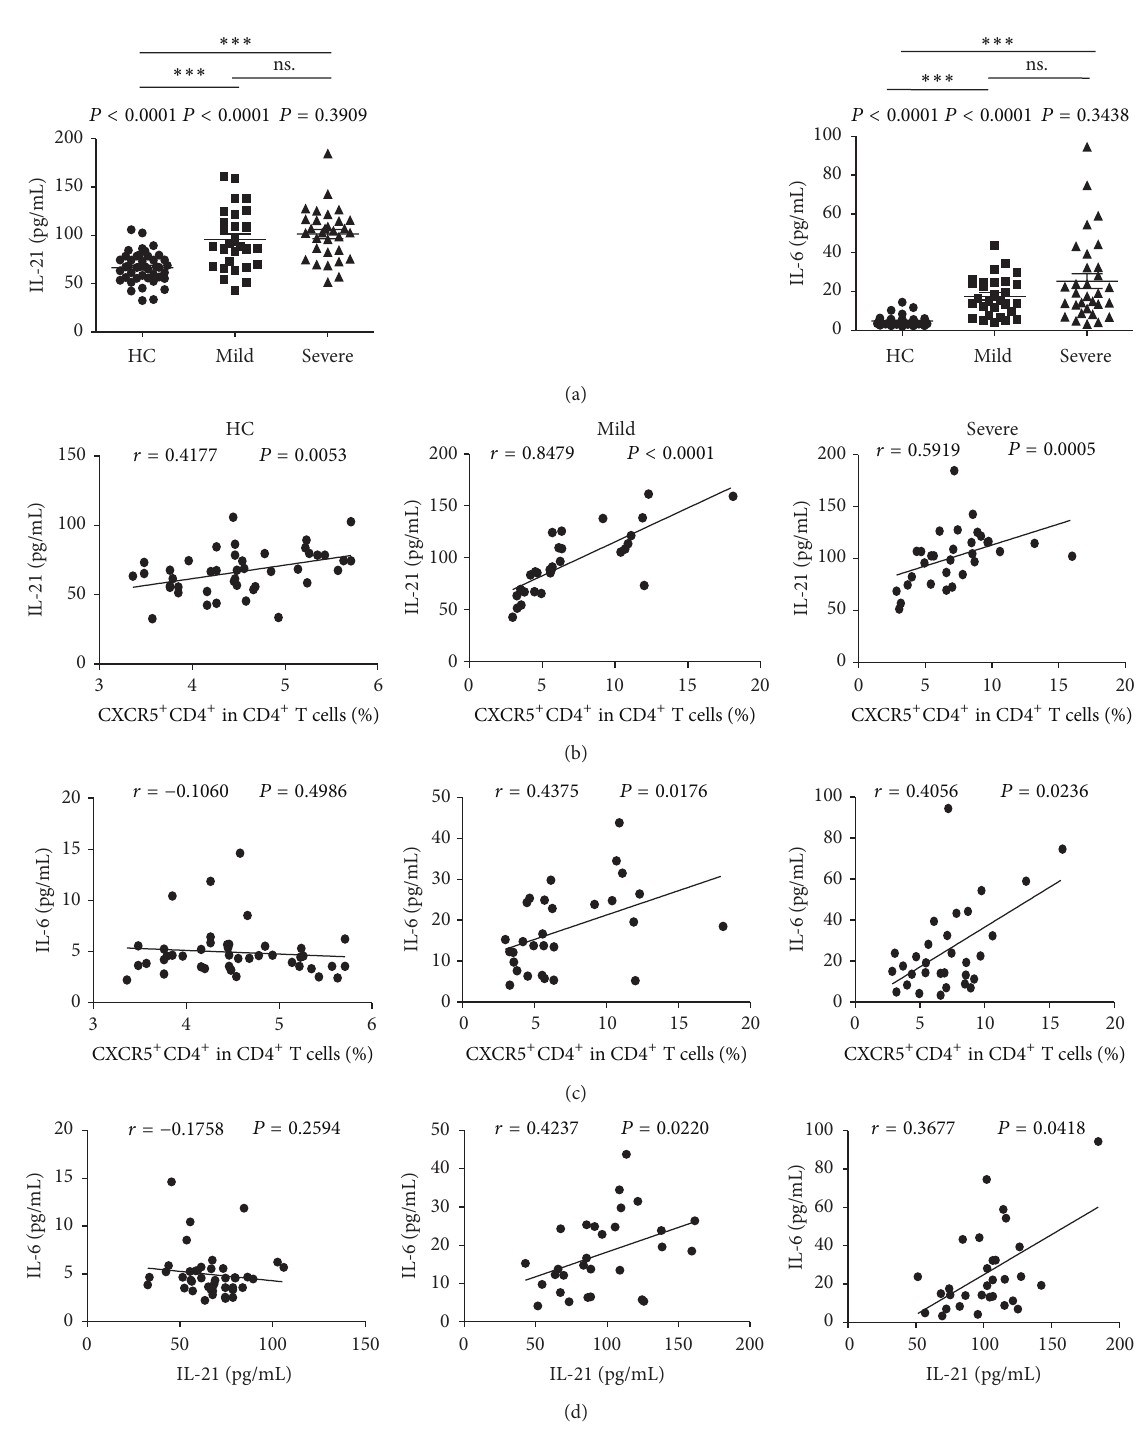
Figure 4: Correlation of cytokines levels and circulating CXCR5 + CD4 + TFH cells in EV71-infected patients including mild and severe cases. (a) Cytokines levels of IL-21 and IL-6 in sera from HC and EV71-infected patients. (b) Relationship between the IL-21 levels and the frequency of circulating CXCR5 + CD4 + TFH cells. (c) Relationship between the IL-6 levels and the frequency of circulating CXCR5 + CD4 + TFH cells. (d) Relationship between the IL-6 levels and IL-21 levels. Data shown were the mean ± SD. The horizontal lines show the median. ∗ 𝑃 < 0.05 ; ∗∗ 𝑃 < 0.01 ; ∗∗∗ 𝑃 < 0.001 ; ns.: no significant